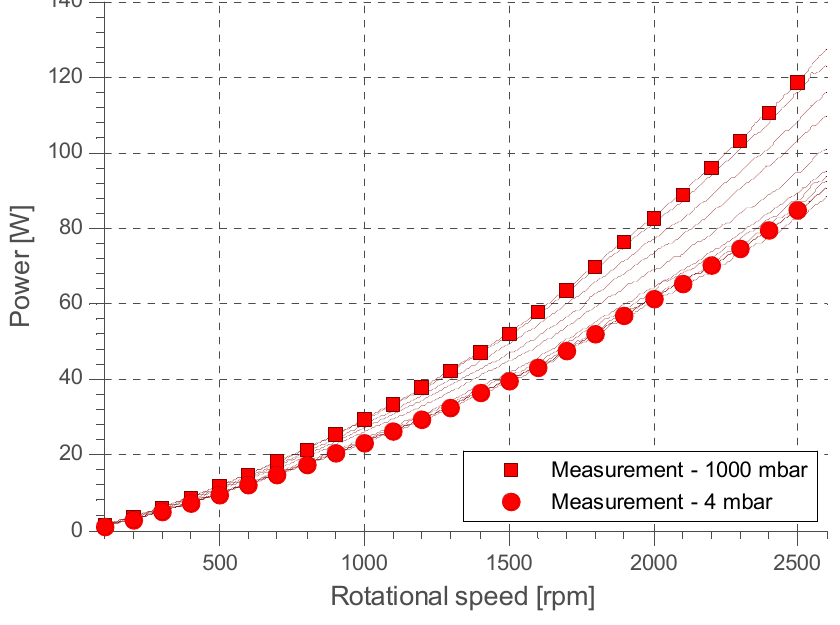
Figure 4. Measurement of power loss during spin-down test. The instantaneous power loss was estimated by numerical derivation of the stored kinetic energy with time. The higher losses correspond to higher pressures. The upper limit correspond to a pressure of 1000 mbar (atmospheric pressure), and the lower limit to 4